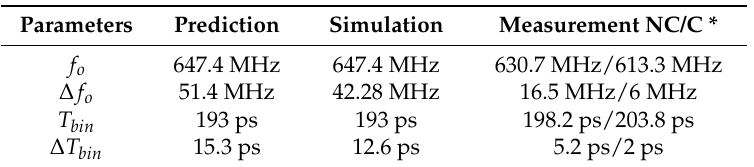
Table 1. Comparative results.